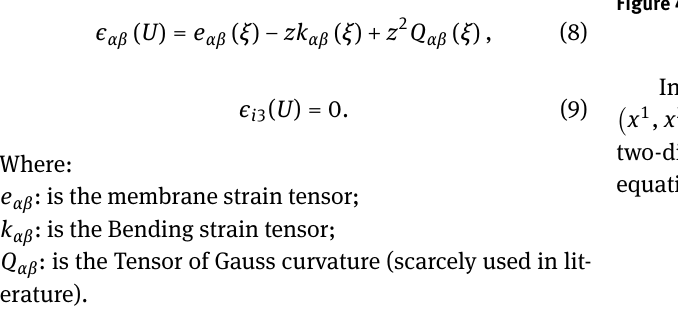
Figure 4: CSFE-sh